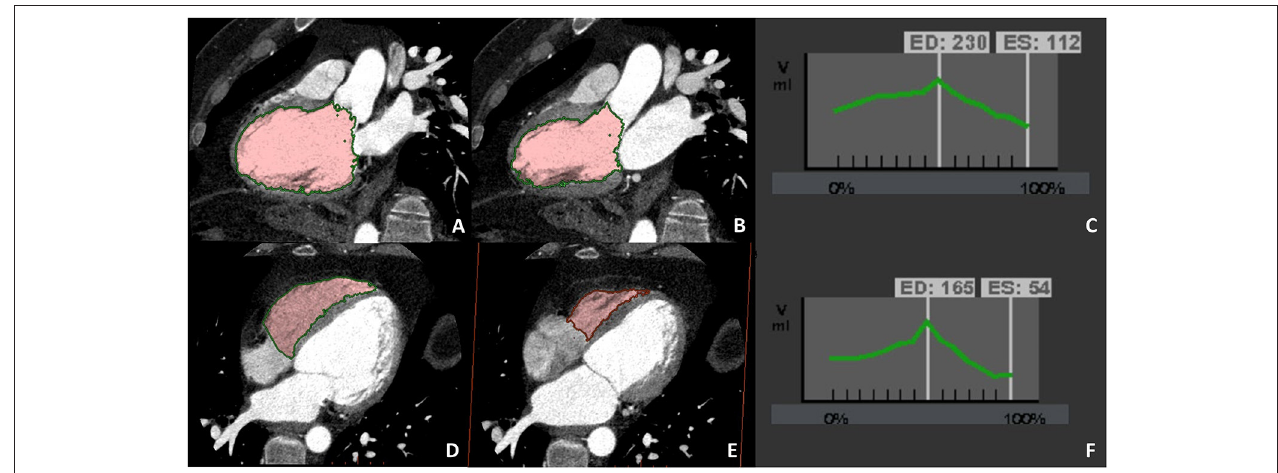
FIGURE 4 | A case example of patients in which biventricular volume and function have been evaluated at CCT due to cardiac magnetic resonance (CMR) contraindication (claustrophobia). Biventricular balanced opacification enabled to correctly quantify both the left (panel A–C ) and right (panel D–F ) ventricular ejection fraction (LVEF 49%, RVEF 68%). Images were acquired during the entire cardiac cycle and the radiation dose needed for this evaluation was 7.5 mSv, heightening one of the main limitations to the routine clinical use of CCT for left ventricular evaluation.